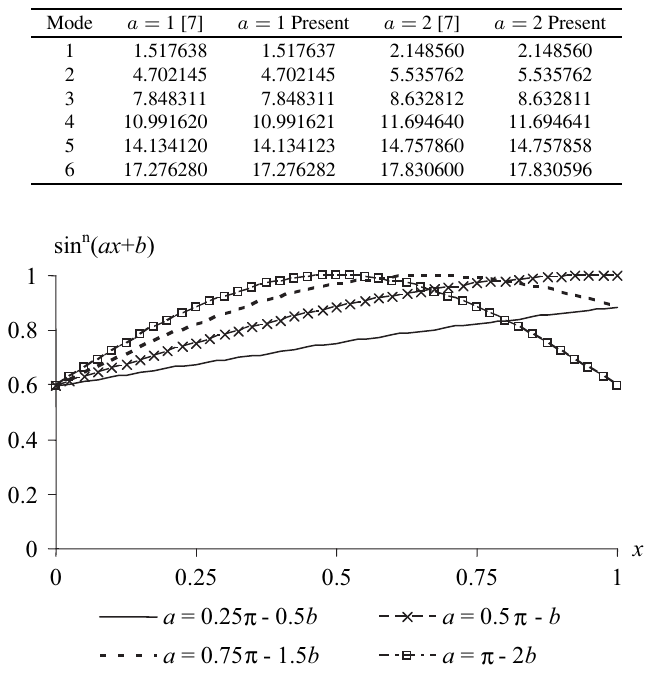
Fig. 1. Graphical illustrations of sin n ( ax + b ) for b = 1, n = 3, and different values of the parameter a .